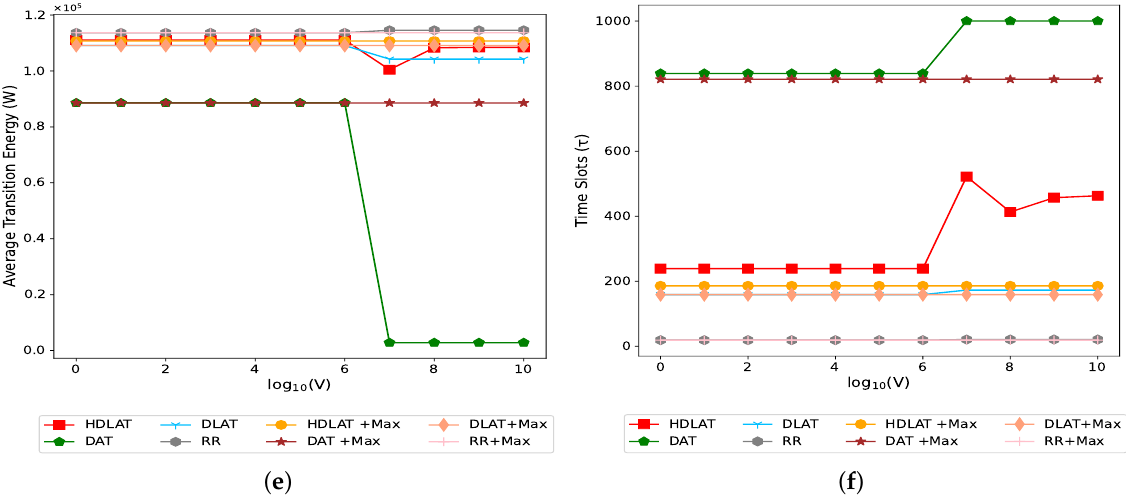
Figure 3. Various Results of A _ UAV . ( a ) Analysis of Average Transmission Power of A _ UAV . ( b ) Analysis of Average Access Latency of A _ UAV . ( c ) Analysis of Average Buffer of A _ UAV . ( d ) Analysis of Hovering Energy of A _ UAV . ( e ) Analysis of Transition Energy of A _ UAV . ( f ) Analy- sis of Total Flight Time of A _ UAV